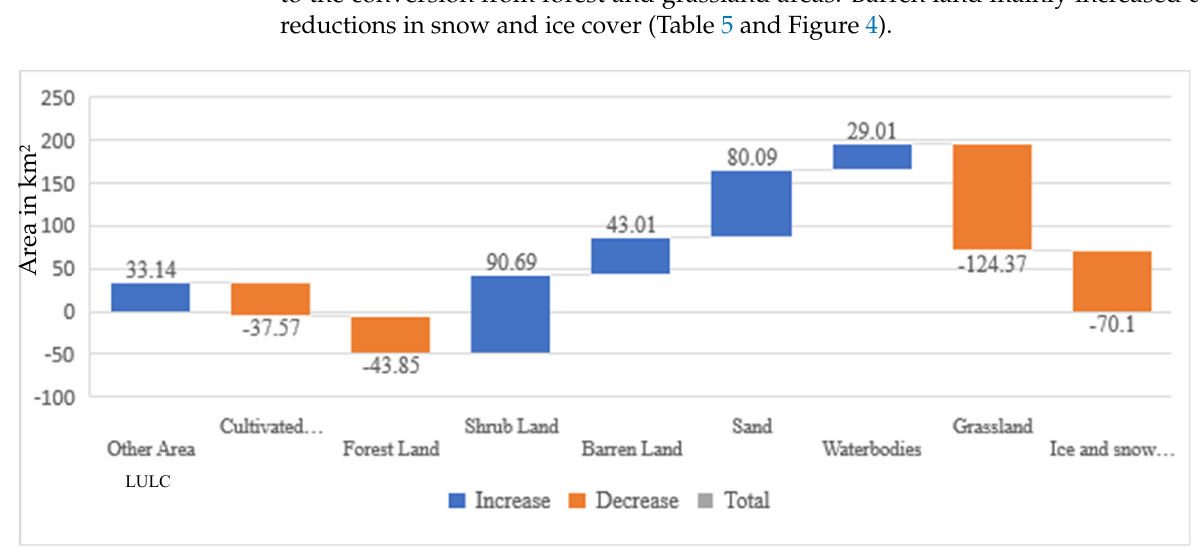
Table 5. LULC transition from 1996 to 2006.